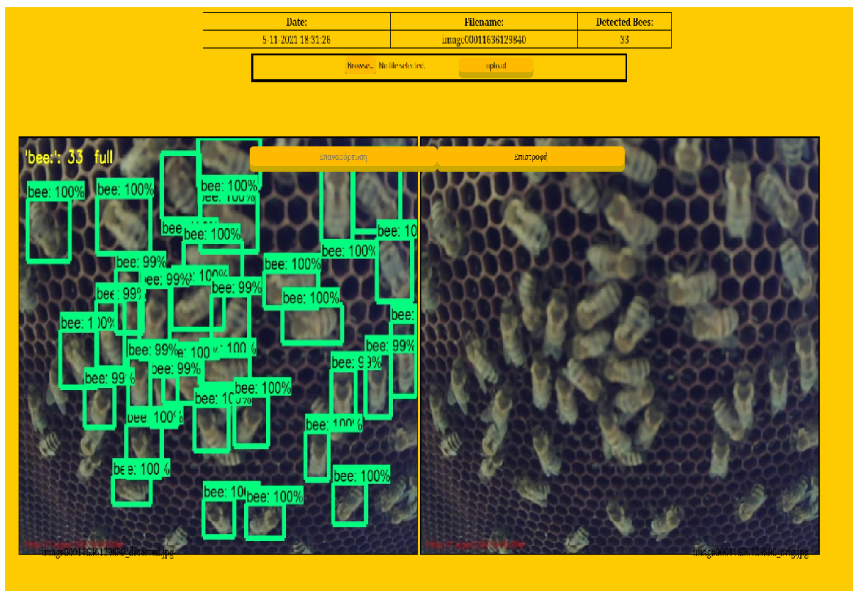
Figure A5. BeeQ RMS web interface to the swarming detection service. It takes as the input uploaded images and performs the offline detection process, illustrating the